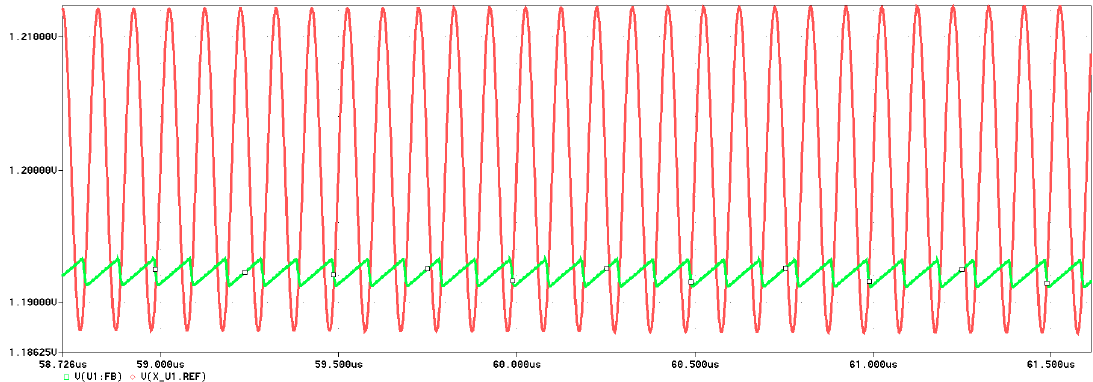
Figure 17. LDO model limitations at 10 MHz.